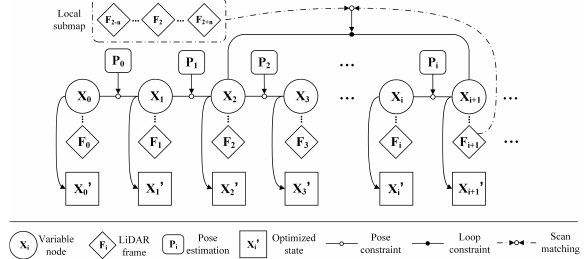
Figure 5. Schematic diagram of factor graph